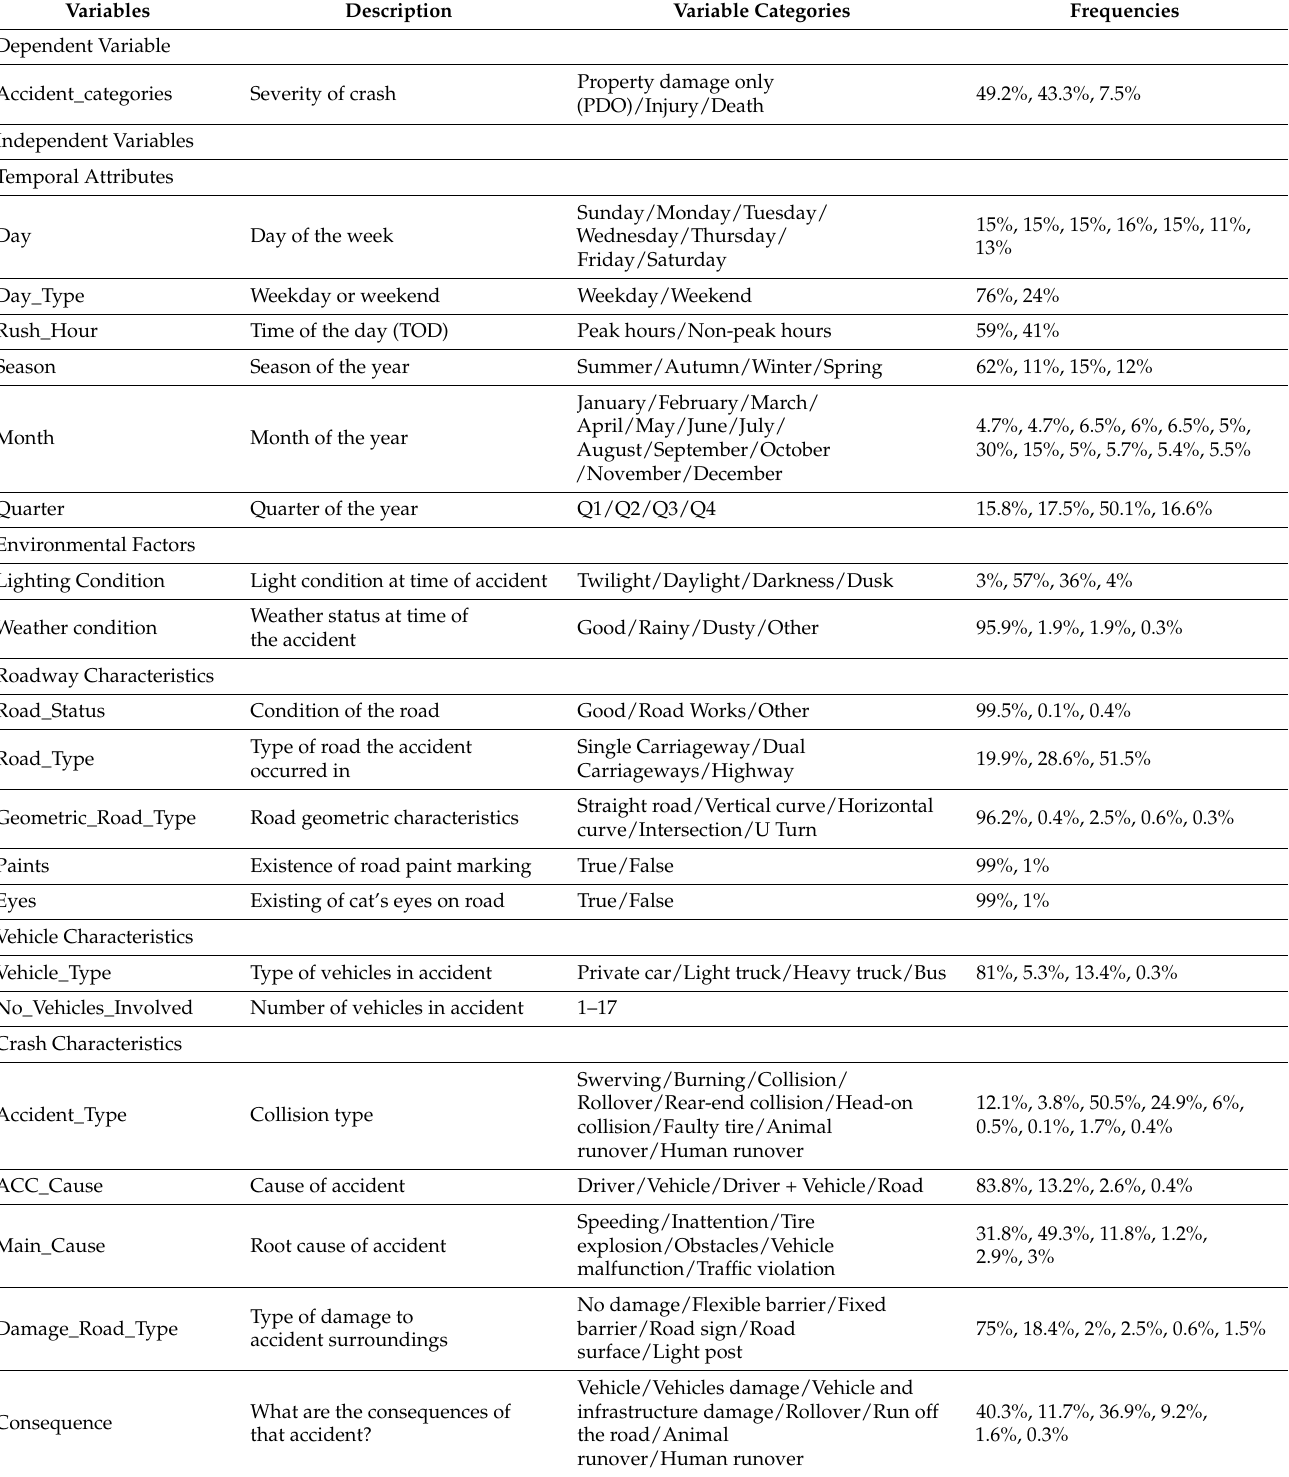
Table 1. Descriptive statistics of research data explanatory variables